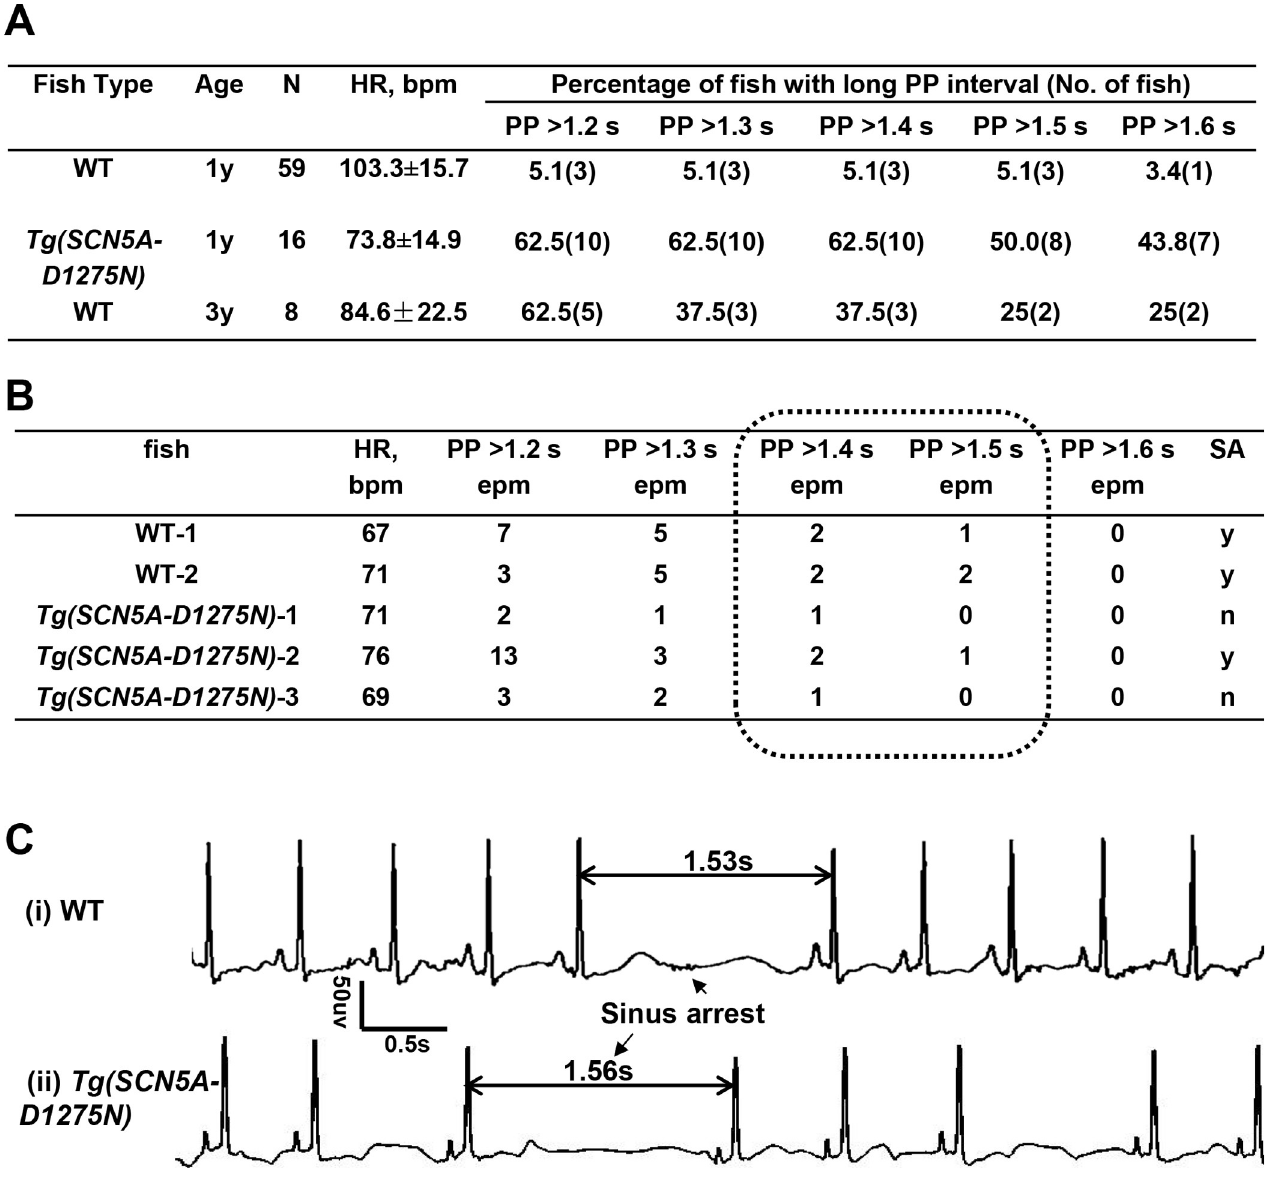
Fig 4. Evidence supports PP interval more than 1.5 seconds as a criterion to define a Sinus Arrest (SA) episode in adult zebrafish. A, Summary of electrocardiographic (ECG) data from 59 wild-type (WT) and 16 Tg(SCN5A-D1275N) fish at 1 year old. Different cut-offs of PP intervals were used to determine an episode of SA. B, Two wild-type (WT) fish and 3 Tg(SCN5A-D1275N) fish that were considered to have SA when 1.2 seconds was used as cut-off, but not if 1.6 seconds was used as cut-off, were further analyzed by reviewing the raw ECG. We considered WT fish 1 and 2 and Tg fish 2 as SA-positive, and others were not because of low frequency of long PP interval. An PP interval more than 1.5 seconds was recommended as a criterion to define SA in zebrafish. C, Representative SA episodes in a WT fish and a Tg(SCN5A-D1275N) fish. epm indicates episodes per